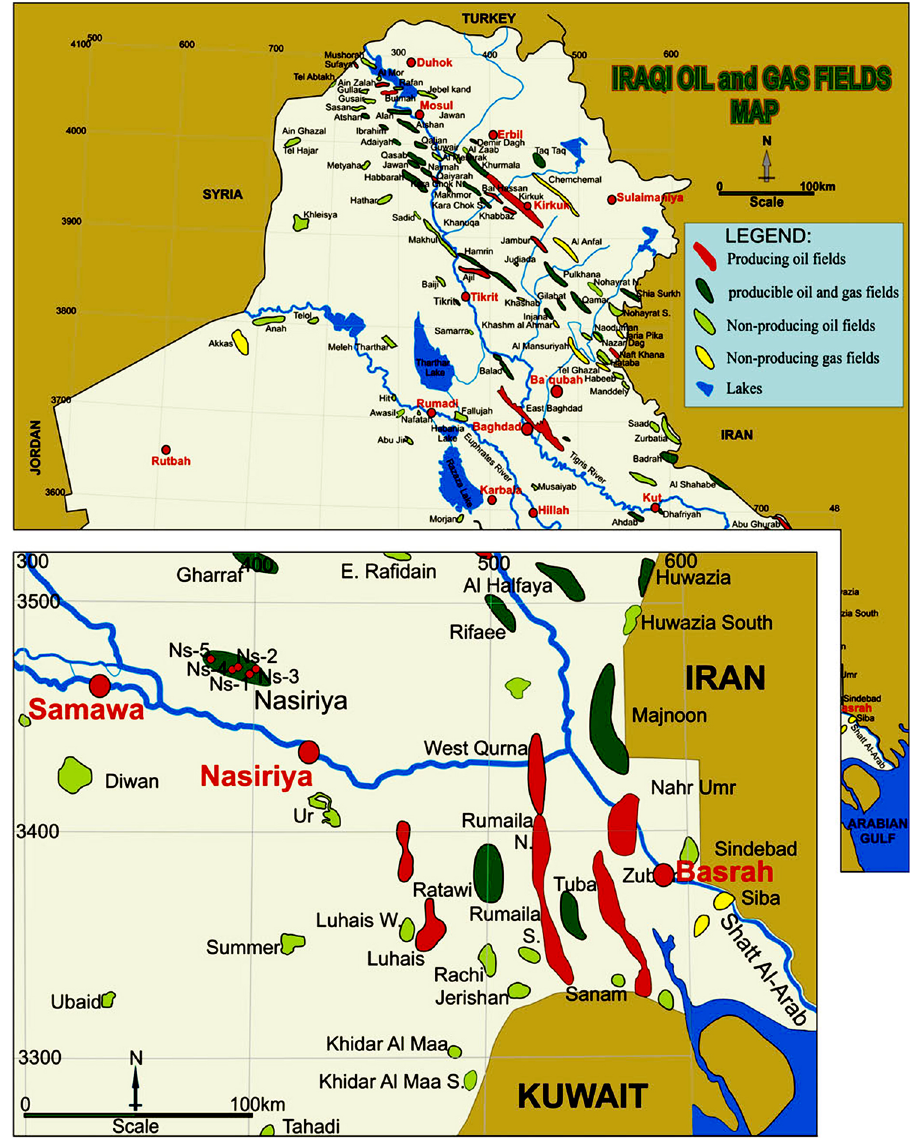
Fig. 1 Location map of Zubair oilfield, southern Iraq (Al- Khafaji